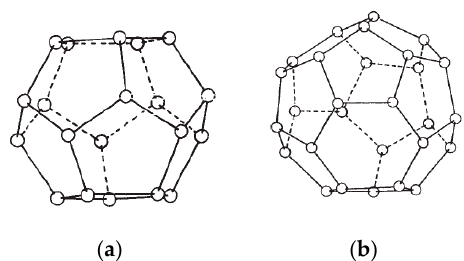
Figure 1. Type II hydrate structures of small cage and large cage. ( a ) Dodecahedron 12-sided polyhedron (small cage); ( b ) hexakaidecahedron 16-sided polyhedron (large cage).